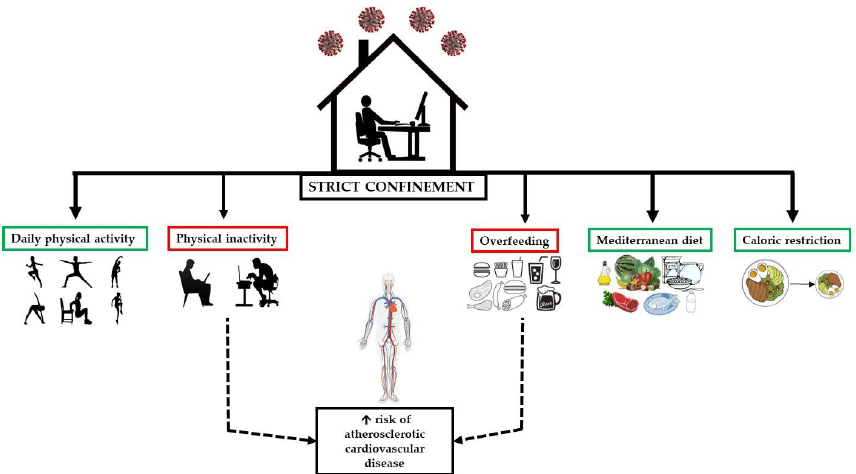
Figure 1. Consequences of overfeeding and reduced physical activity.